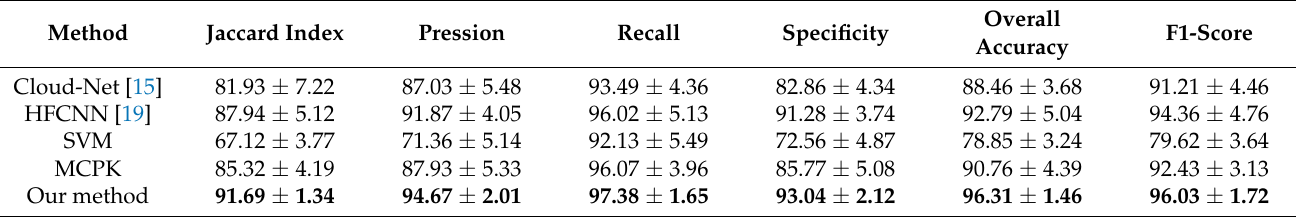
Table 2. Performance on GF-1_WHU test dataset (mean ± variance